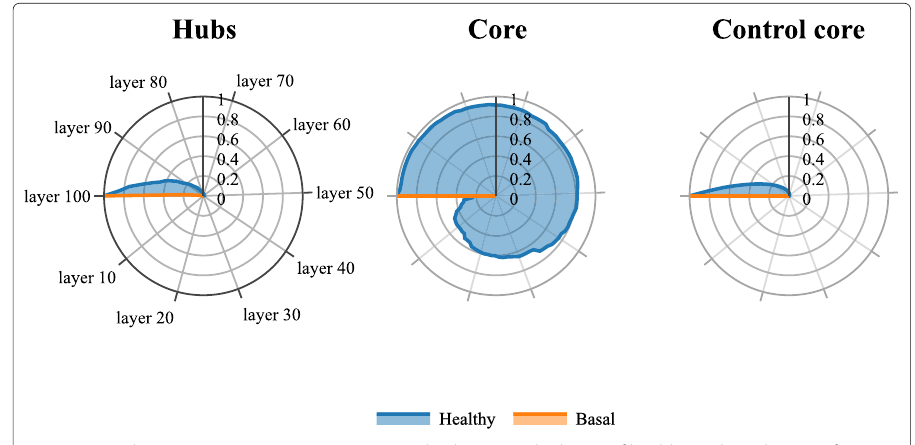
Fig. 7 Cumulative conservation ratio ( ccr , see Methods) across the layers of healthy and Basal GCNs of two sets of highly connected nodes of the top layer: hubs and nodes in the core of the network. The rightmost figure represents the ccr of nodes in the core of the top co-expression layer of a randomly generated multilayer network using stochastic block models (see